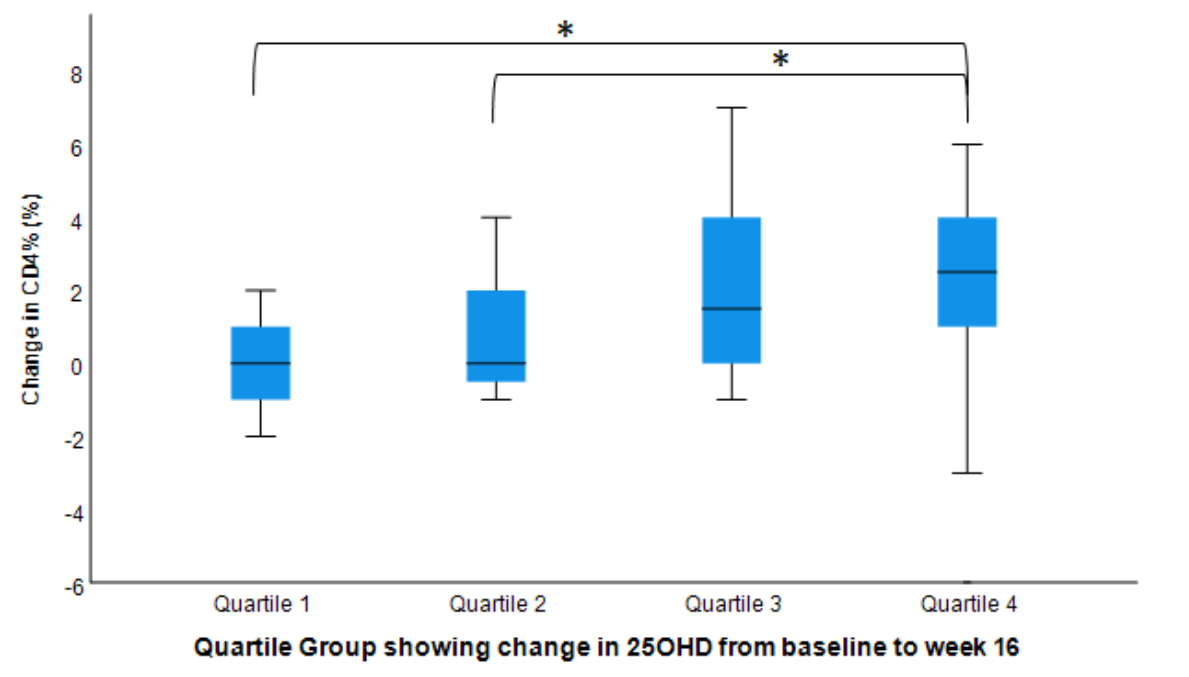
Figure 4. Changes in CD4 + % by serum 25(OH)D changes (post- vs. pre-intervention values). Model adjusted for baseline value, age, sex, BMI, and seasons of the year (n = 50). Bar plot shows medians with IQR and standard deviations from mean. Group 1 had the lowest quartile delta change in 25OHD and Group 4 had the highest. *Mean change for Group 4 was significantly different from Groups 1 and 2 but not Group 3 ( p < 0.05). No significant differences found among Groups 1, 2 and 3.